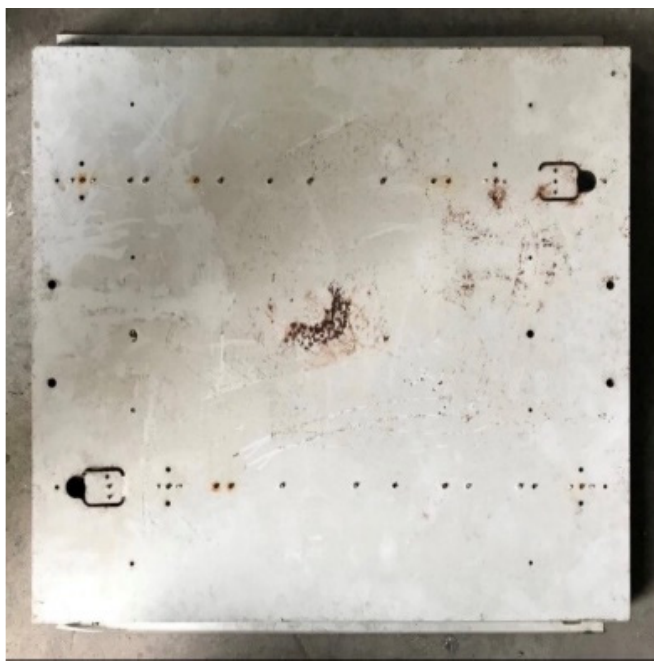
Figure 13. Conventional luminaire (L) with mounting screw holes on the back.